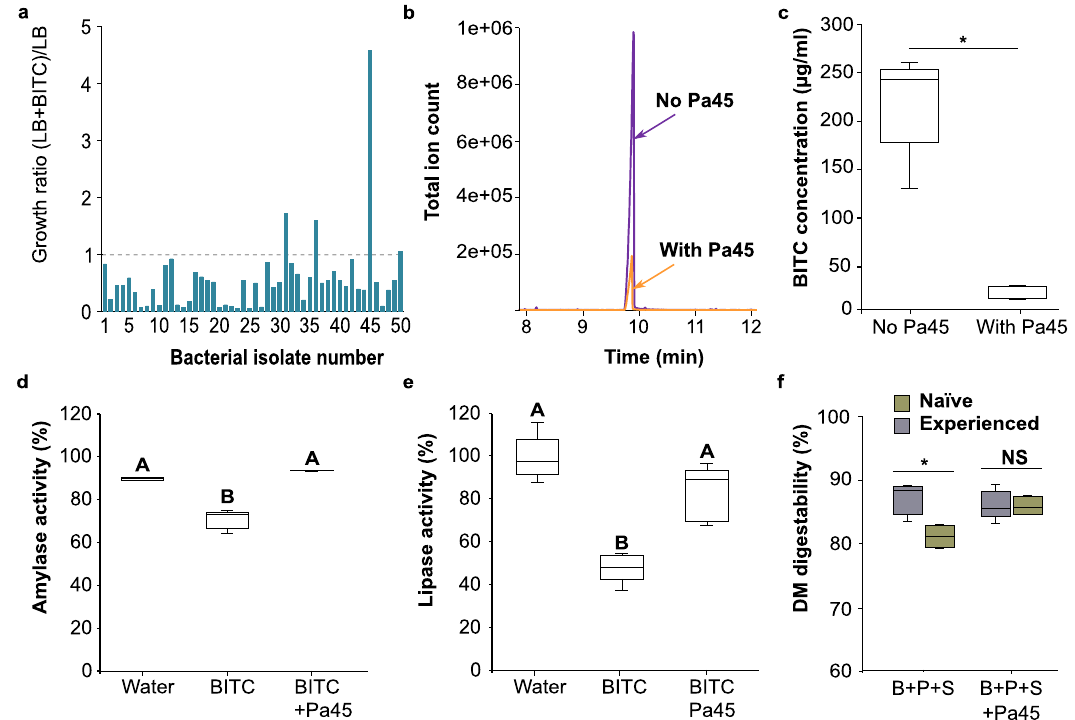
Fig. 4 | Pantoea (isolate 45, 100% sequence similarity to ASV0003, see Sup- plementary Fig. S2) grow and remove BITC and can remediate inhibition of digestiveenzymesandimprovedigestibilityinbirdsfeedingonamixtureof O. baccatus seeds and pulp. a Screening bacterial colonies extracted from the bird droppingsfortheabilitytogrowinthe presenceof BITC.Theresultsrepresentthe growthratioonLuriaBroth(LB)mediumsupplementedwithBITC(0.1%)relativeto mediumsupplementedwithwater.Thedashedlinerepresentsthepotentialgrowth on the non-supplemented medium. b The mixing of BITCand Pantoea 45bacterial isolate( Pa45 )resultsintheremovalofBITCascanbeseenintherepresentativeGC- MS chromatogram. c Quanti fi cation of BITC removal by Pa45 ; Box centerlines are the median, box limits are the lower quartile (Q1) and upper quartile (Q3),